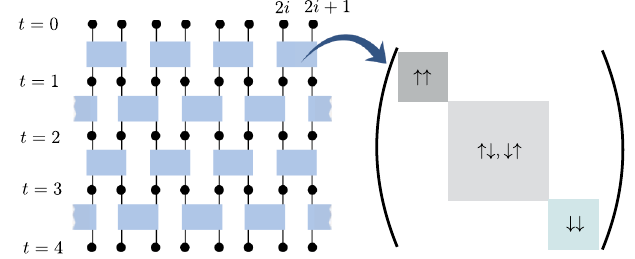
FIG. 1. Left: Diagram of the random unitary circuit. Each site (black dot) is the direct product of a two-state qubit and a q -state qudit. Each gate (blue box) locally conserves S tot z , the total z component of the two qubits it acts upon, and is thus a block- diagonal unitary of the form shown on the right, with each block of each gate independently Haar random. The smaller blocks do not flip the qubits and thus operate only on the two qudits, while the larger block also produces S tot z -conserving qubit “ flip flops ”